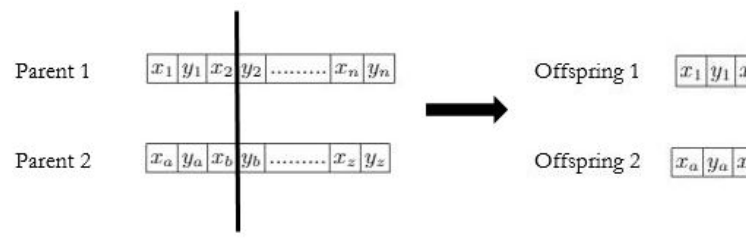
Figure 5. Single point